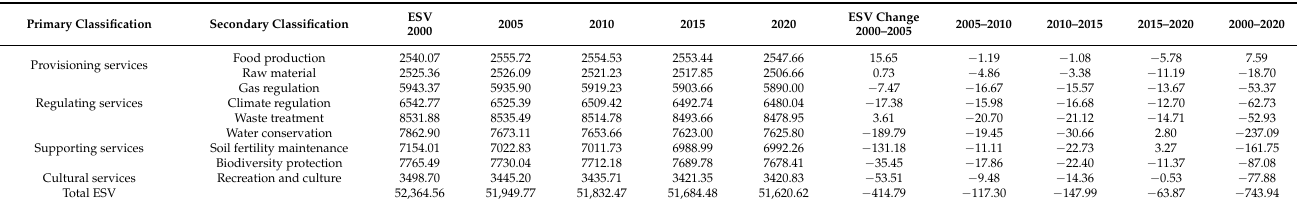
Table 3. Changes in ESV in the study area from 2000 to 2020 (×10 6 yuan·yr − 1 ) .